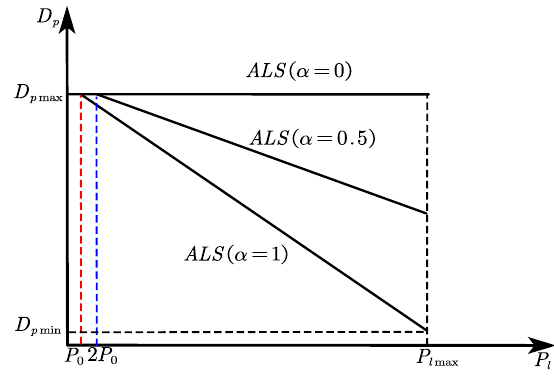
Figure 8. Load-sensitive characteristics for ASL-EHA.